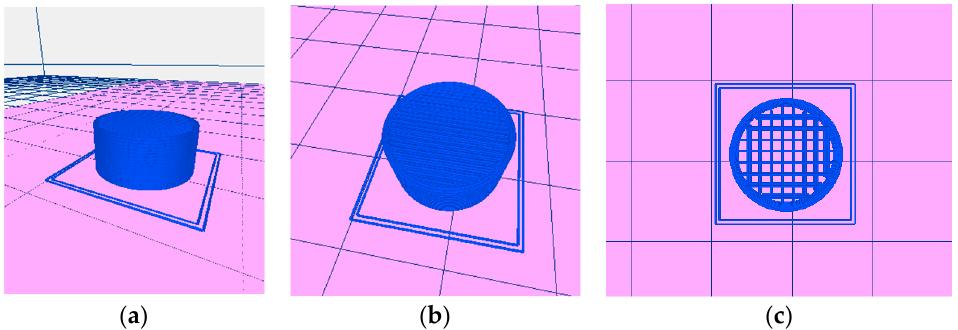
Figure 1. Image of the design of the 3DP tablets: ( a ) perimeters, ( b ) solid top layers, and ( c ) internal mesh.